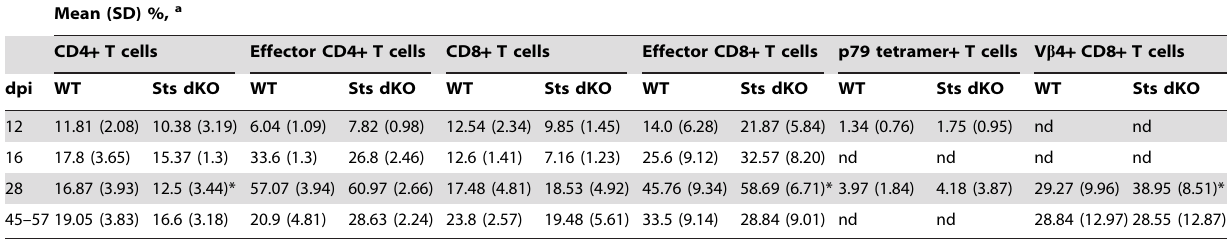
Table 2. T cell subsets in the spleens of infected mice.